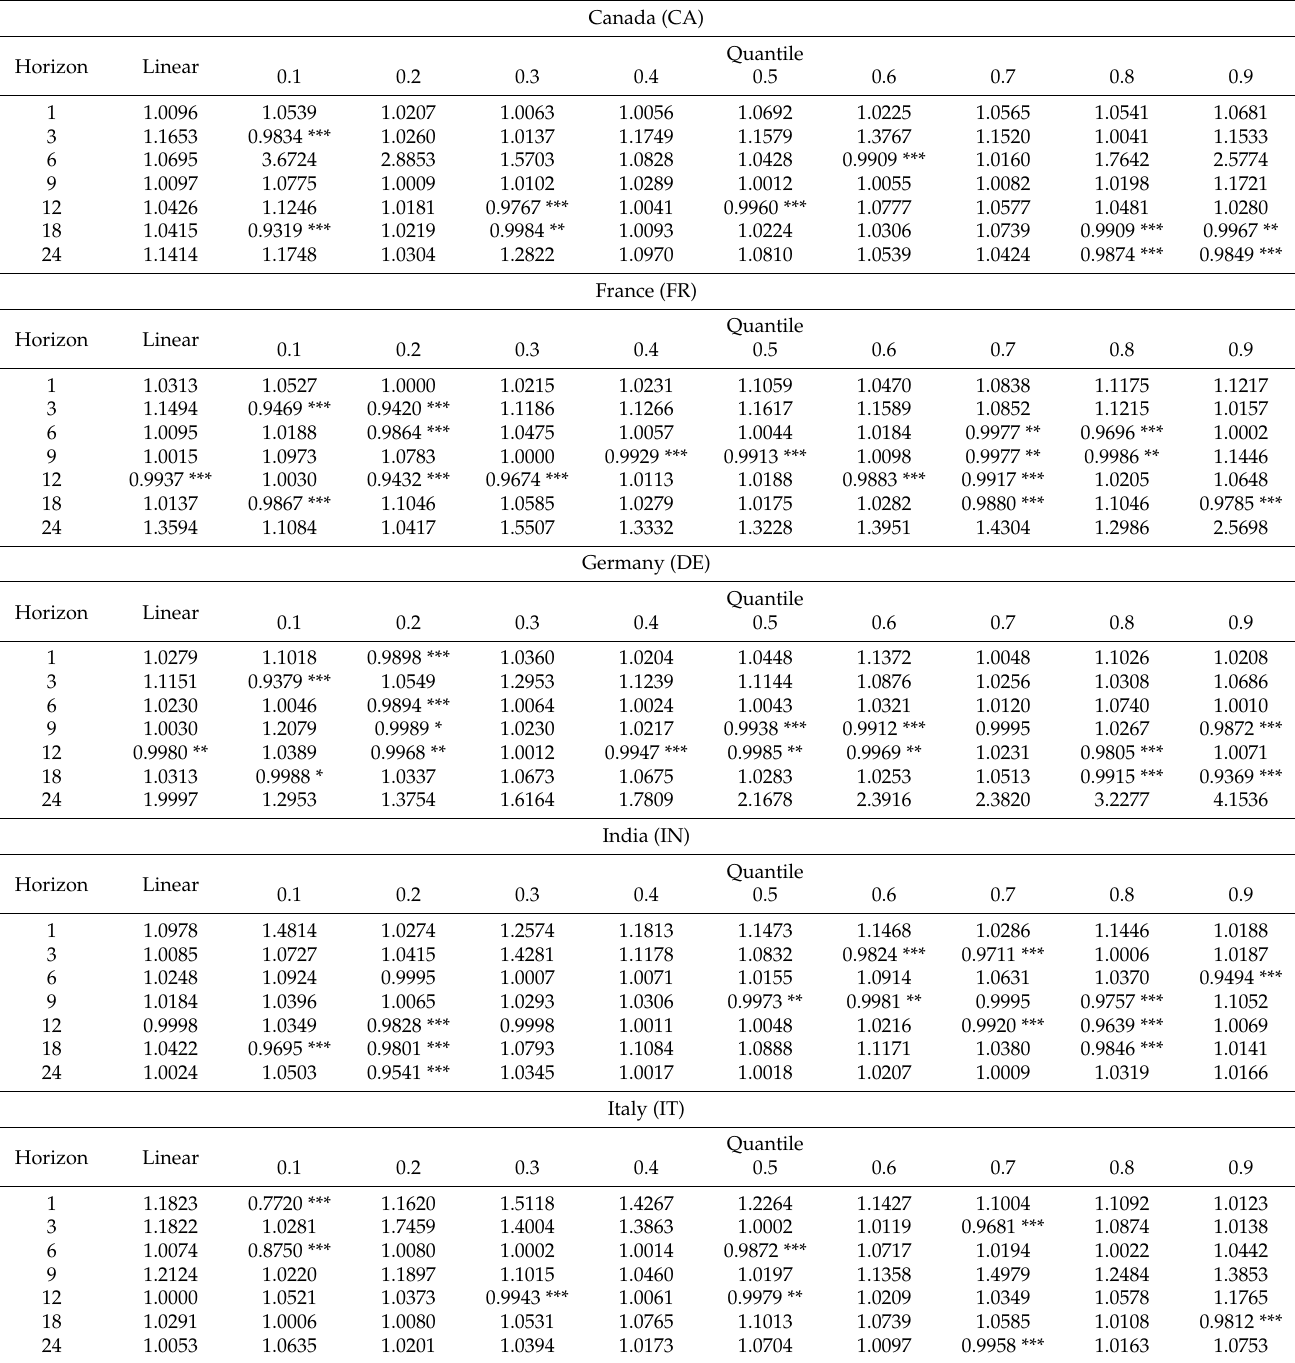
Table A4. Alternative forecasting